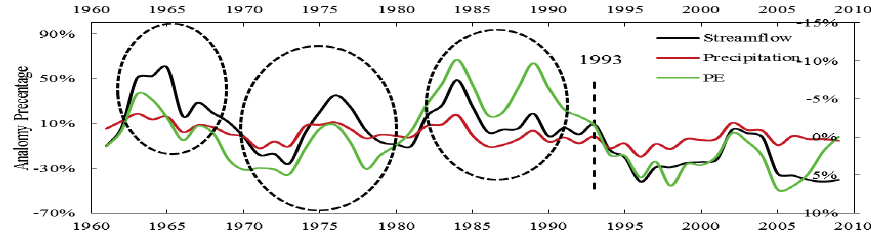
Fig. 3 The change of trend between runoff, precipitation and PE in Beiluohe River basin.